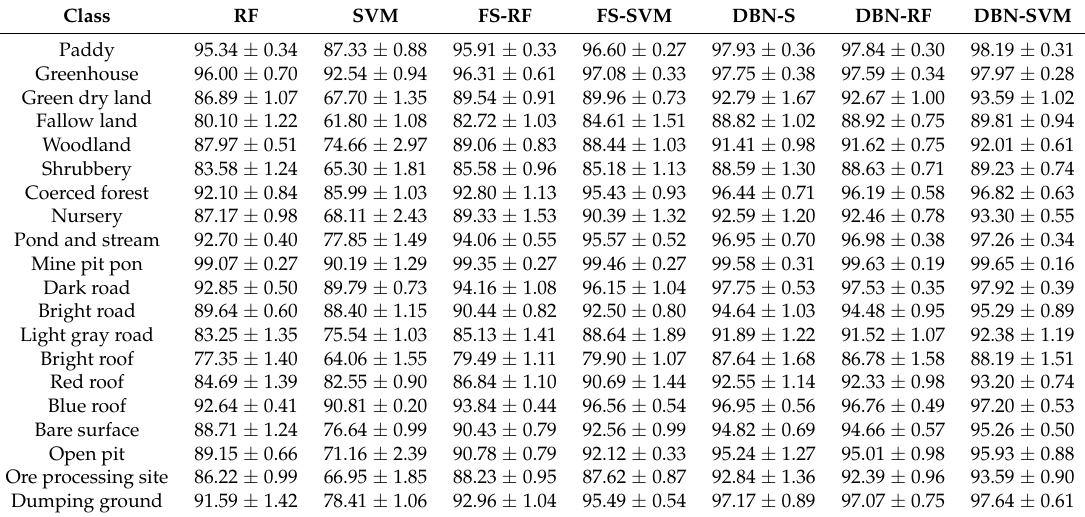
Table 9. F1-measure values (%) for different land covers obtained by different classification models. RF: random forest. SVM: support vector machine. FS-RF: RF with feature selection (FS) method. FS-SVM: SVM with FS method. DBN-S: deep belief network (DBN) with softmax classifier. DBN-RF: the fused model of DBN and RF. DBN-SVM: the fused model of DBN and SVM.